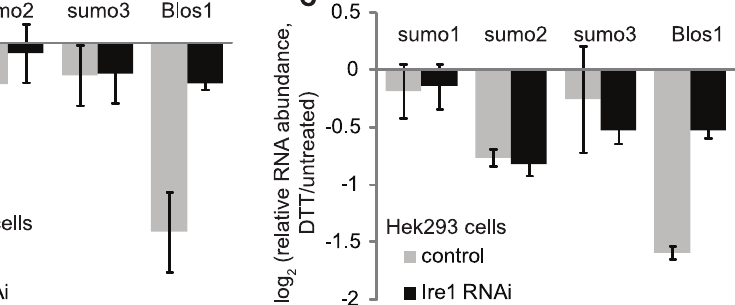
Figure 3. Sumo mRNA is not strongly affected by ER stress in mammalian cells. A. Conservation of the Ire1 site and surrounding region in sumo transcripts across species. The stem loop is indicated above the sequences and the region aligning with the loop from D. melanogaster sumo is shown in red. Deviations from the D. melanogaster sequence in the stem loop region are shown in blue. While most species have a conserved loop sequence, perfect basepairing in the stem is present only in the fly and mouse sequences. B-C. We either mock-treated (control) or used siRNA to deplete Ire1 a from MC3T3-E1 mouse osteoblastic fibroblasts (panel B) or Hek293 human kidney cells (panel C). We then compared RNA levels in the presence and absence of DTT (2 mM, 4.5 hrs), by qPCR. Blos1, a RIDD target in mouse and humans, is shown as a control. Except for Blos1, the differences in mRNA levels between control and Ire1 siRNA-treated cells were not statistically significant. Shown are the averages and SDs for 2–3 independent experiments.